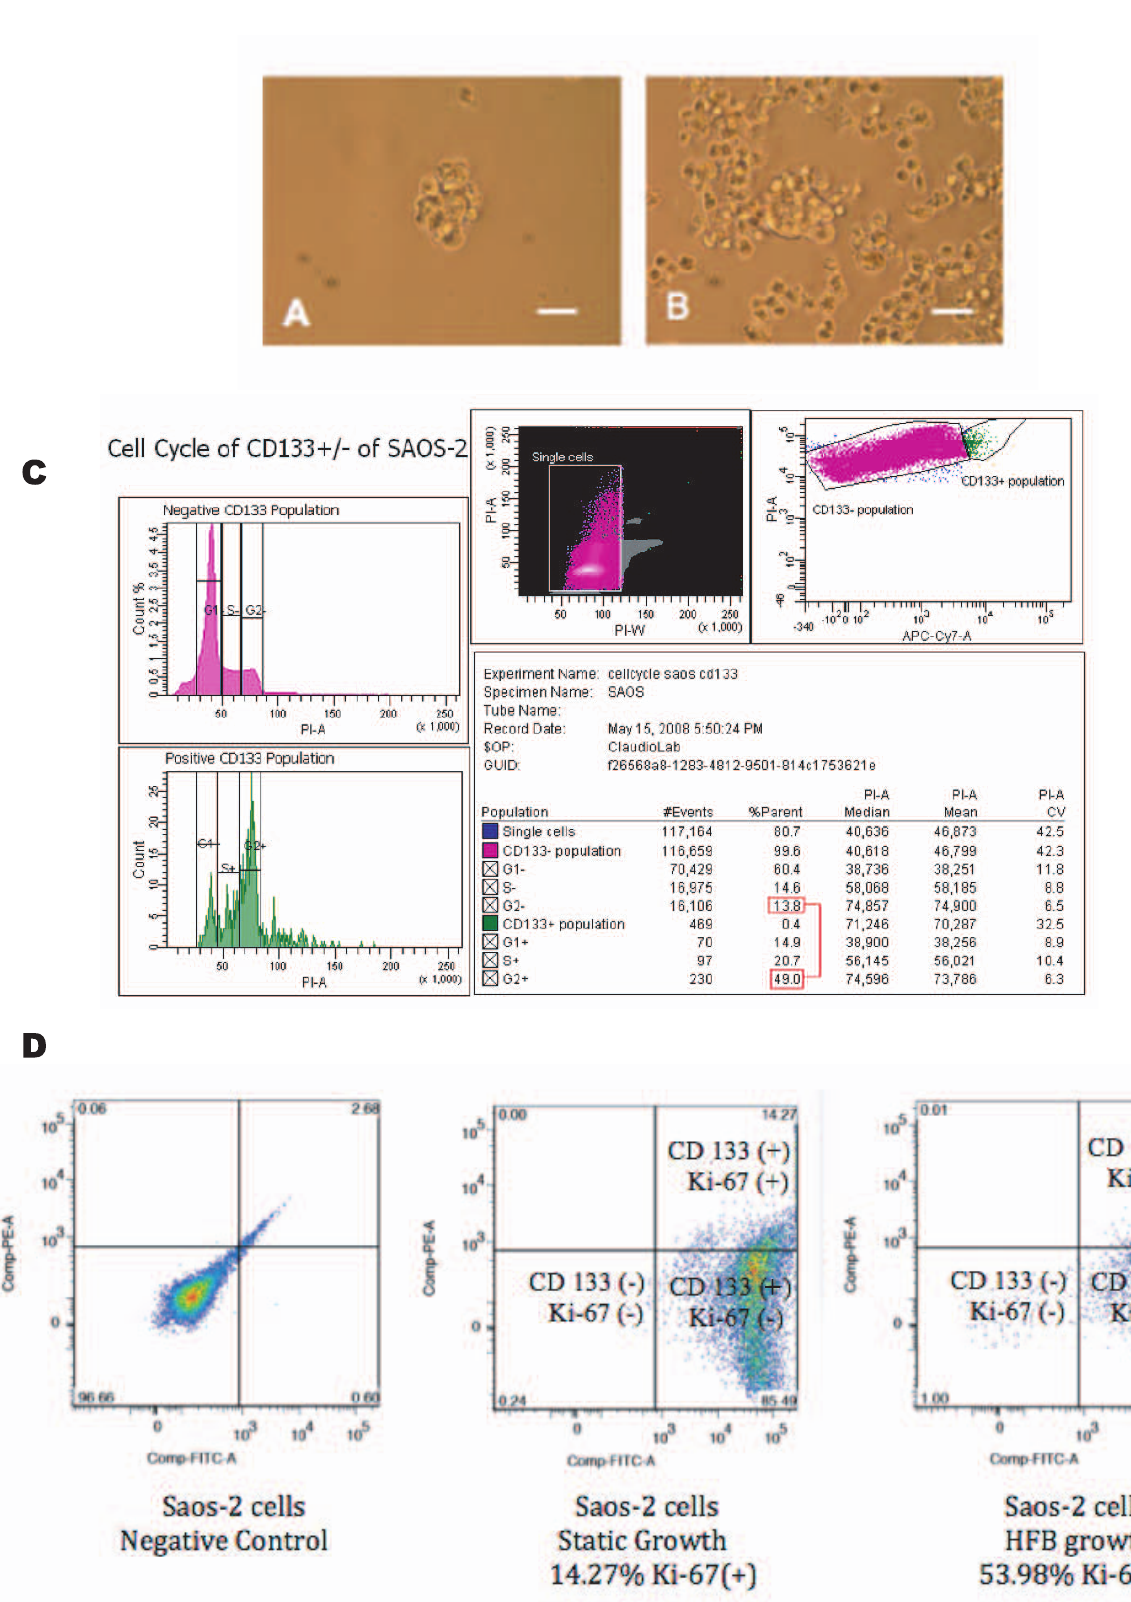
Figure 6. The SAOS-2 cell line is composed of two distinct populations. A ) Contrast phase microscopy of a soft agar assay of parental SAOS- 2 cells. B ) Contrast phase microscopy of a soft agar assay of HFB CD133( + ) proliferated SAOS-2 cells. C ) Propidium iodide flow cytometry analysis of SAOS-2 cells grown in 1-G culture sorted by their CD133 status showing two distinct populations: the CD133( + ) and CD133( 2 ) cells with a different